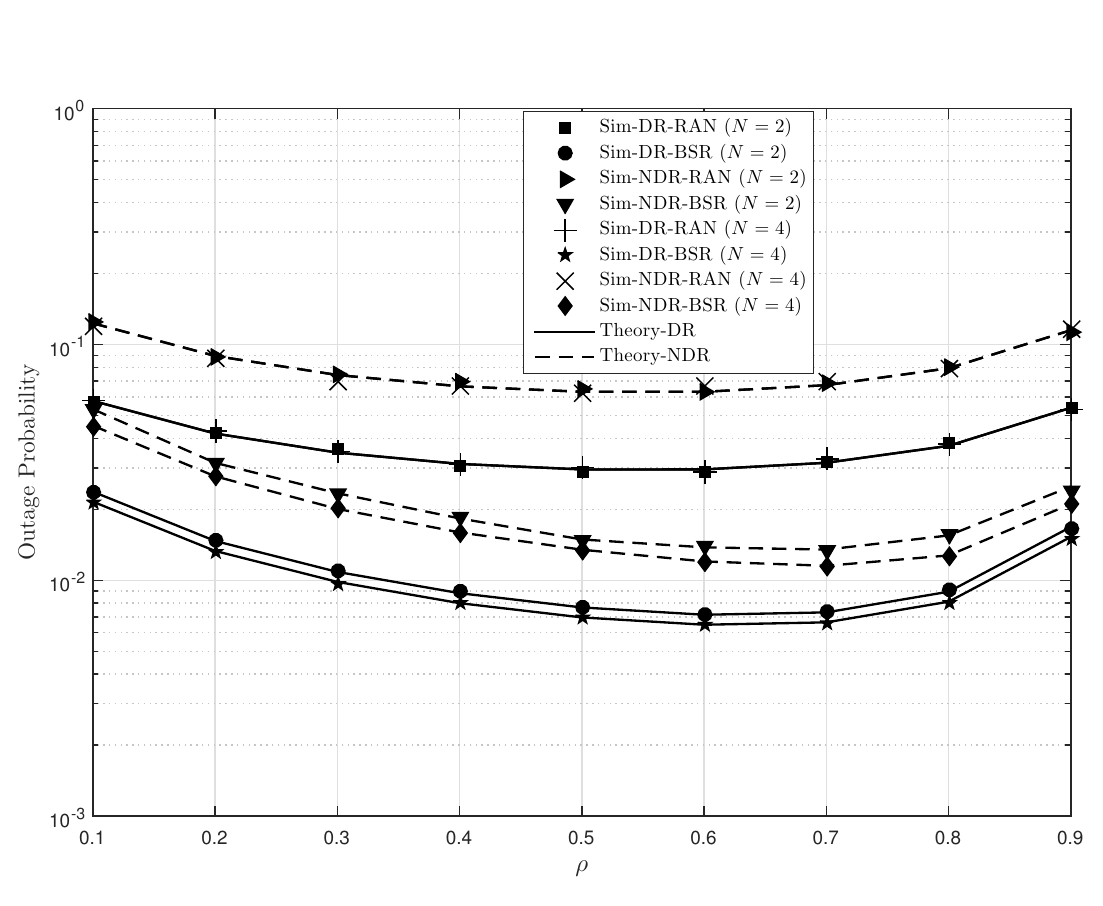
Figure 3. Outage probability versus power splitting ratio ρ for the four protocols and for N of 2 and 4 with ( x ( x R 2 , y R 2 ) = (0 . 5 , − 0 . 3) , P = 5 dB, ψ t = 1 bits/s/Hz, ρ = 0 . 5 , η = 0 . 5 , and M = 2